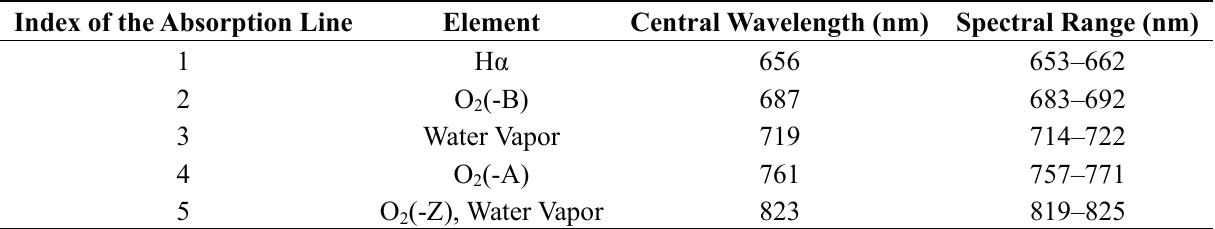
Table 2. The notations, central wavelengths, and spectral ranges of the five absorption lines used for Fs